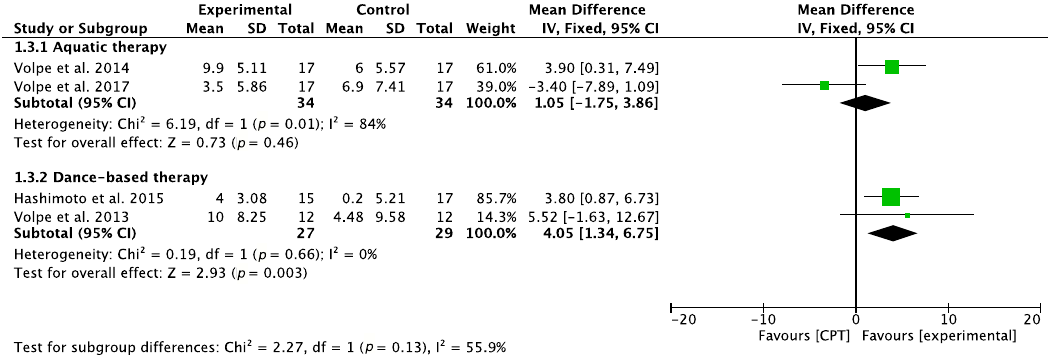
Figure 4. Forest plot for balance measured by BBS. Green block indicates the weight assigned to the study and the horizontal line depicts the confidence interval. Black rhombus shows the overall result. The bold words highlight the total/subtotal values and the different modalities of therapies used in the interventions.